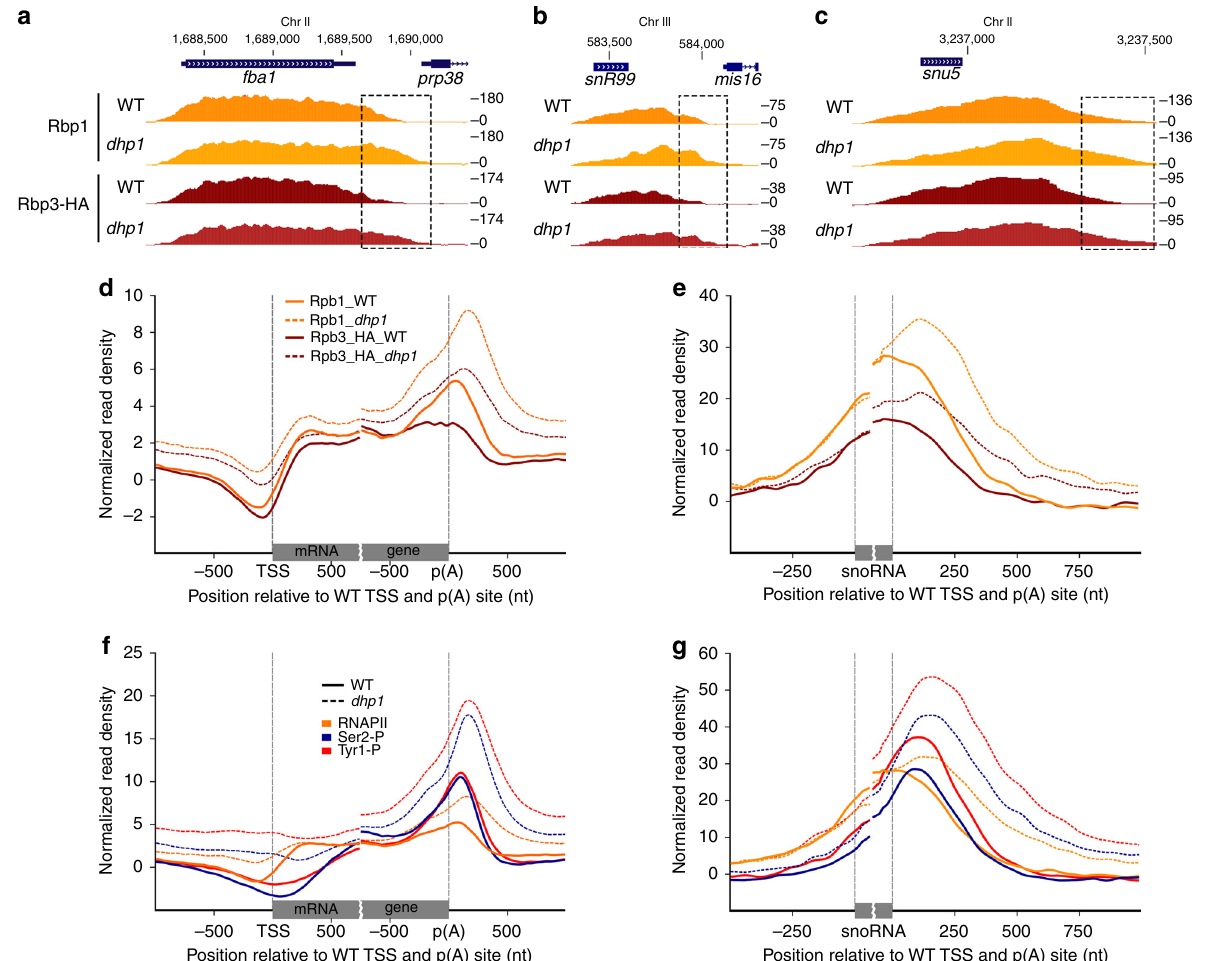
Fig. 5 The torpedo nuclease Dhp1 is required for transcription termination of coding and ncRNA genes. a – c Normalized ChIP-seq signal of RNAPII subunits Rbp1 and Rbp3 in WT and Dhp1-depleted strains across the fba1 mRNA ( a ), the snR99 snoRNA ( b ), and the snu5 snRNA ( c ) genes grown in thiamine- treated minimal medium for 15 h. The dashed-line rectangles highlight delayed transcription termination in Dhp1-de fi cient cells. d – g Average ChIP-seq pro fi le of Rbp1 and Rbp3 ( d , e ) or total RNAPII (Rbp1), Ser2-P, and Tyr1-P ( f , g ) in WT (solid lines) or Dhp1-depleted (dotted lines) cells across 4755 mRNA ( d – f ) and 24 monocistronic snoRNA ( e , g ) genes with a mapped p(A) site in thiamine-treated minimal